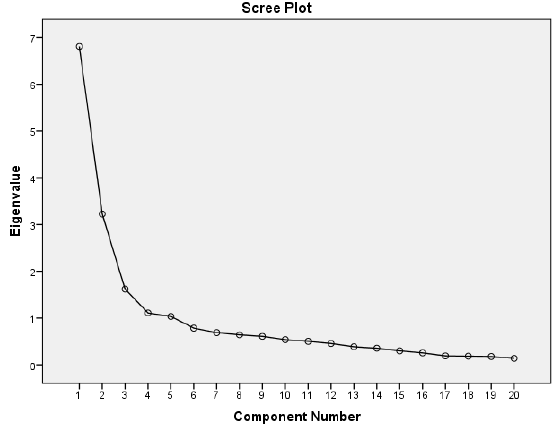
Figure 2. Scree plot of SHALOM–Lived Experience. Table 3. Exploratory factor loadings for the two sections of SHALOM.